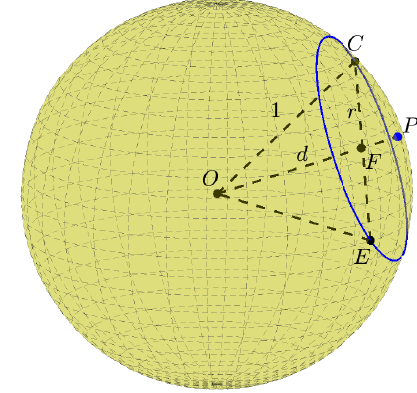
Figure 4. The relation between d and the circle radius r . P is a primary point on a unit sphere. The blue circle is the primary circle of radius r defined by P . The triangle CFO is